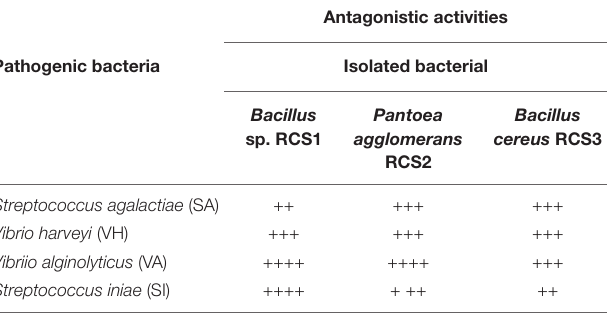
TABLE 3 | Antagonistic activity of isolated bacterial strains against selected fish